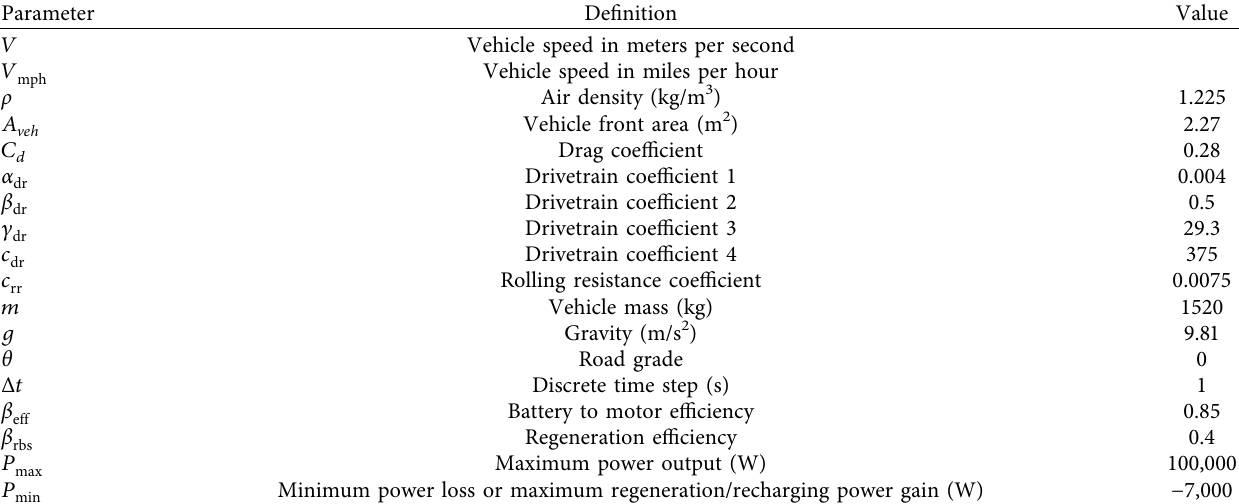
Table 2: EV power consumption model parameters.